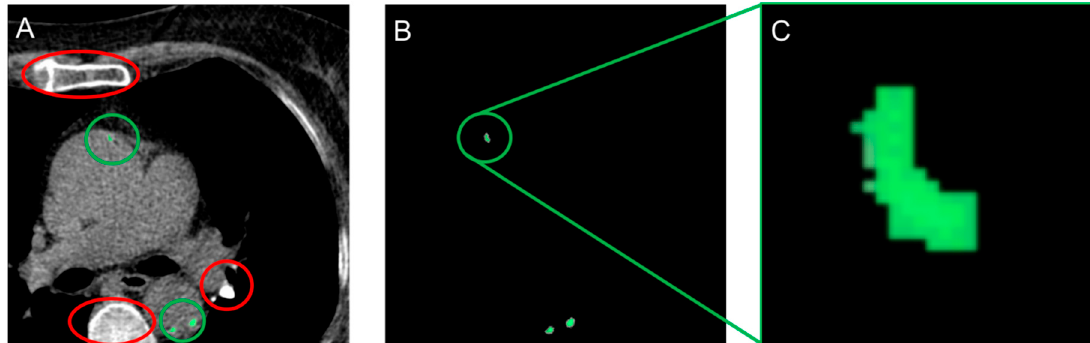
Figure 1. ( A ) Annotation in DICOM format requires differentiation between several non-cardiac structures with HU > 130 such as the vertebrae and sternum (red), and cardiac calcium (green). ( B and ×15 magnification, C ) The colored annotation in DICOM format is extracted using color-based K-means clustering. Abbreviations: DICOM = Digital Imaging and Communications in Medicine, HU = Hounsfield units.